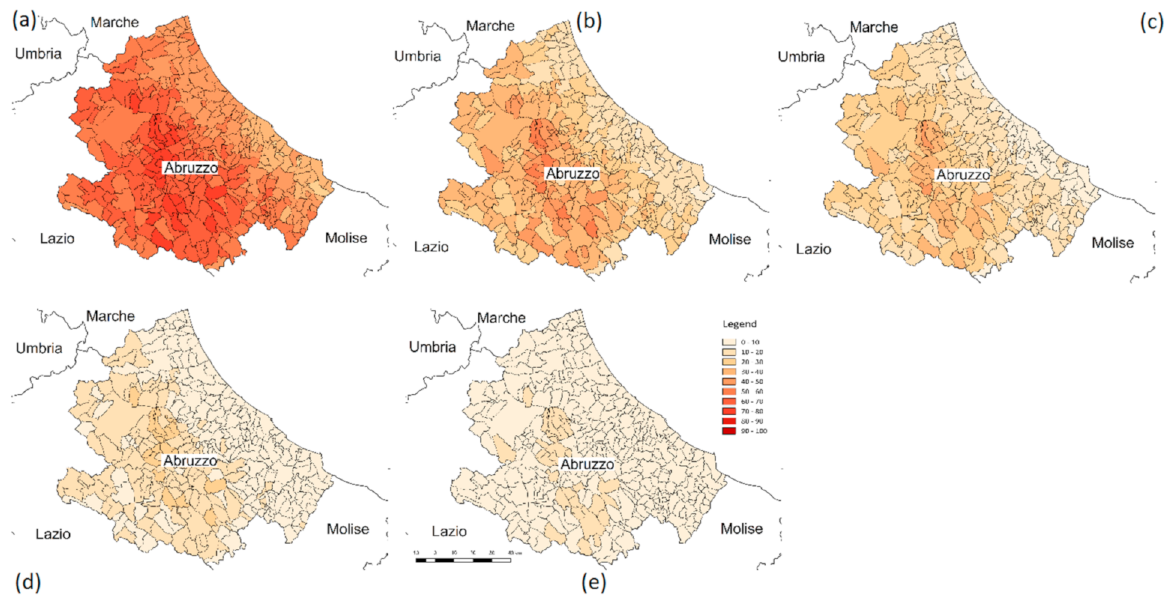
Figure 7. Abruzzo damage risk maps for an observation window of 50 years: ( a ) D1, ( b ) D2, ( c ) D3, ( d ) D4, ( e ) D5. Percentage of municipality URM buildings reaching corresponding damage